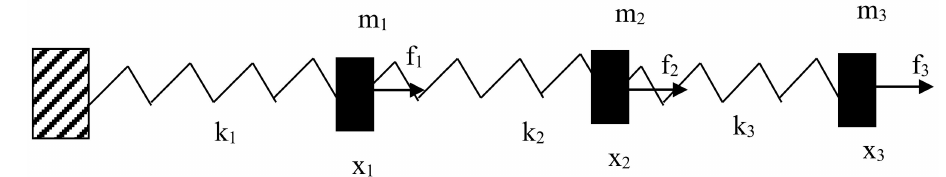
Figure 6. Mass-spring system with three degrees of freedom.